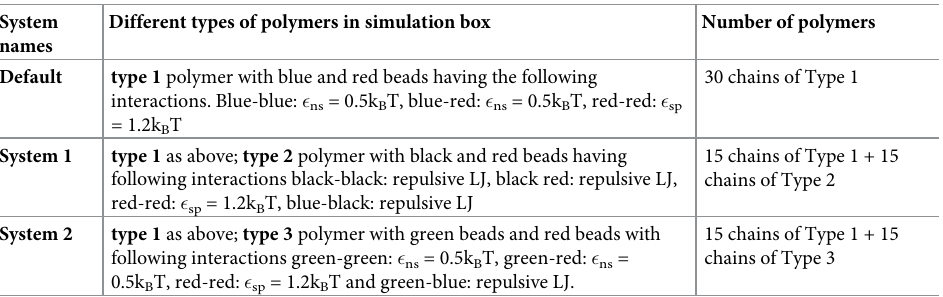
Table 2. Heterogeneous mix of polymer definition and interaction involved in them and number of polymers in the